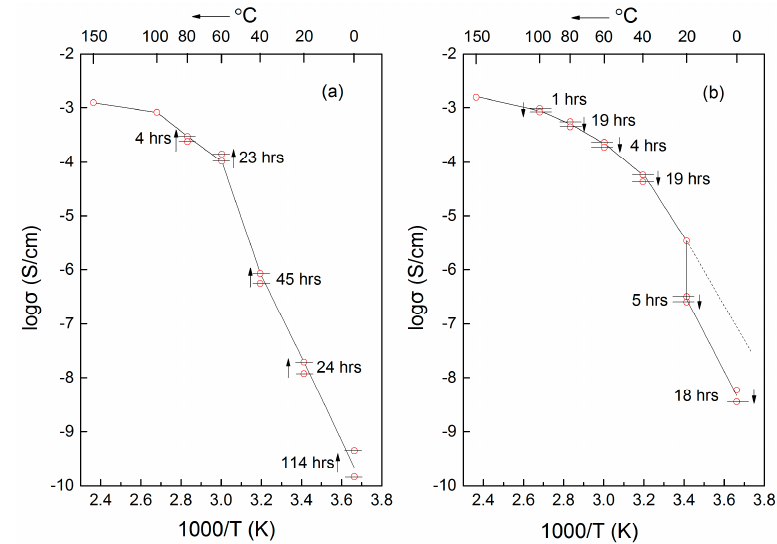
Figure 19. ( a ) Conductivity of PEO (2,000,000 g/mol)–LiBF 4 (EO:Li + = 8)–TiO 2 (20 wt %, d = 21 nm) CPE heat-treated at 150 °C for 30 min and then quenched to 0 °C; ( b ) Conductivity of the same CPE heat-treated at 150 °C for 30 min. The conductivity was measured while the specimen was slowly cooled from the high temperature and then stabilized at the temperature of measurement. Data from Kumar et al. [182].